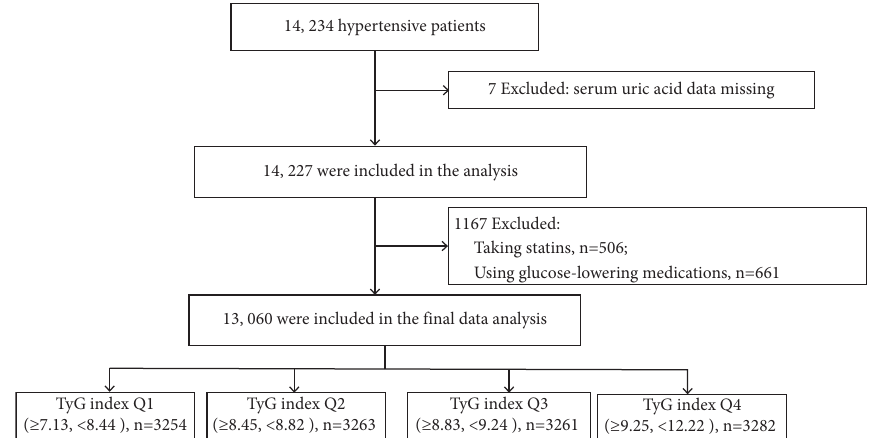
Figure 1: Flowchart of the study population